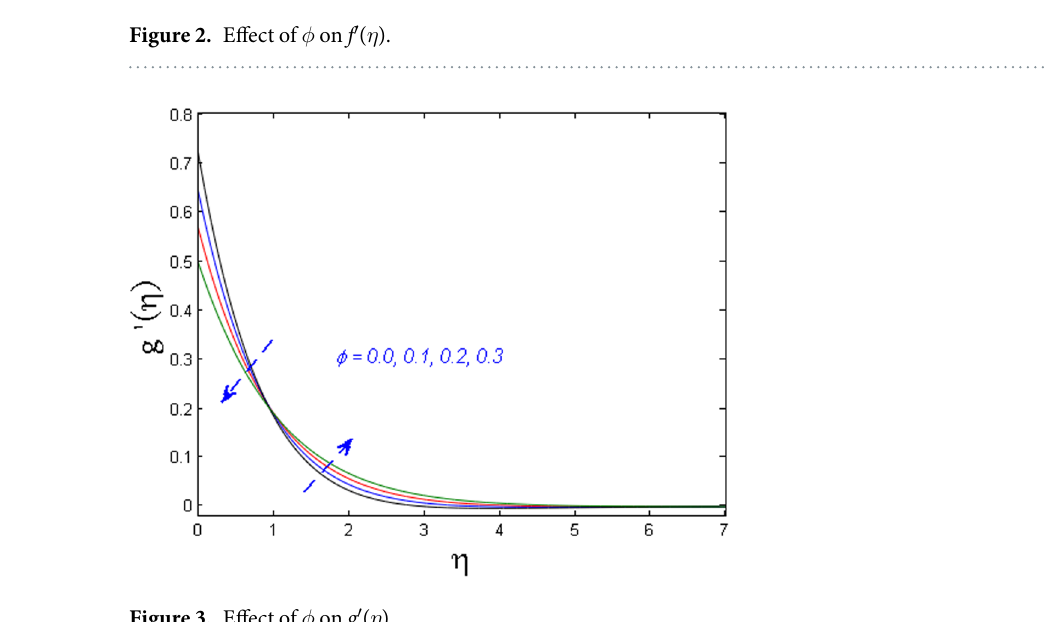
Figure 3. Effect of φ on g ′ ( η ).